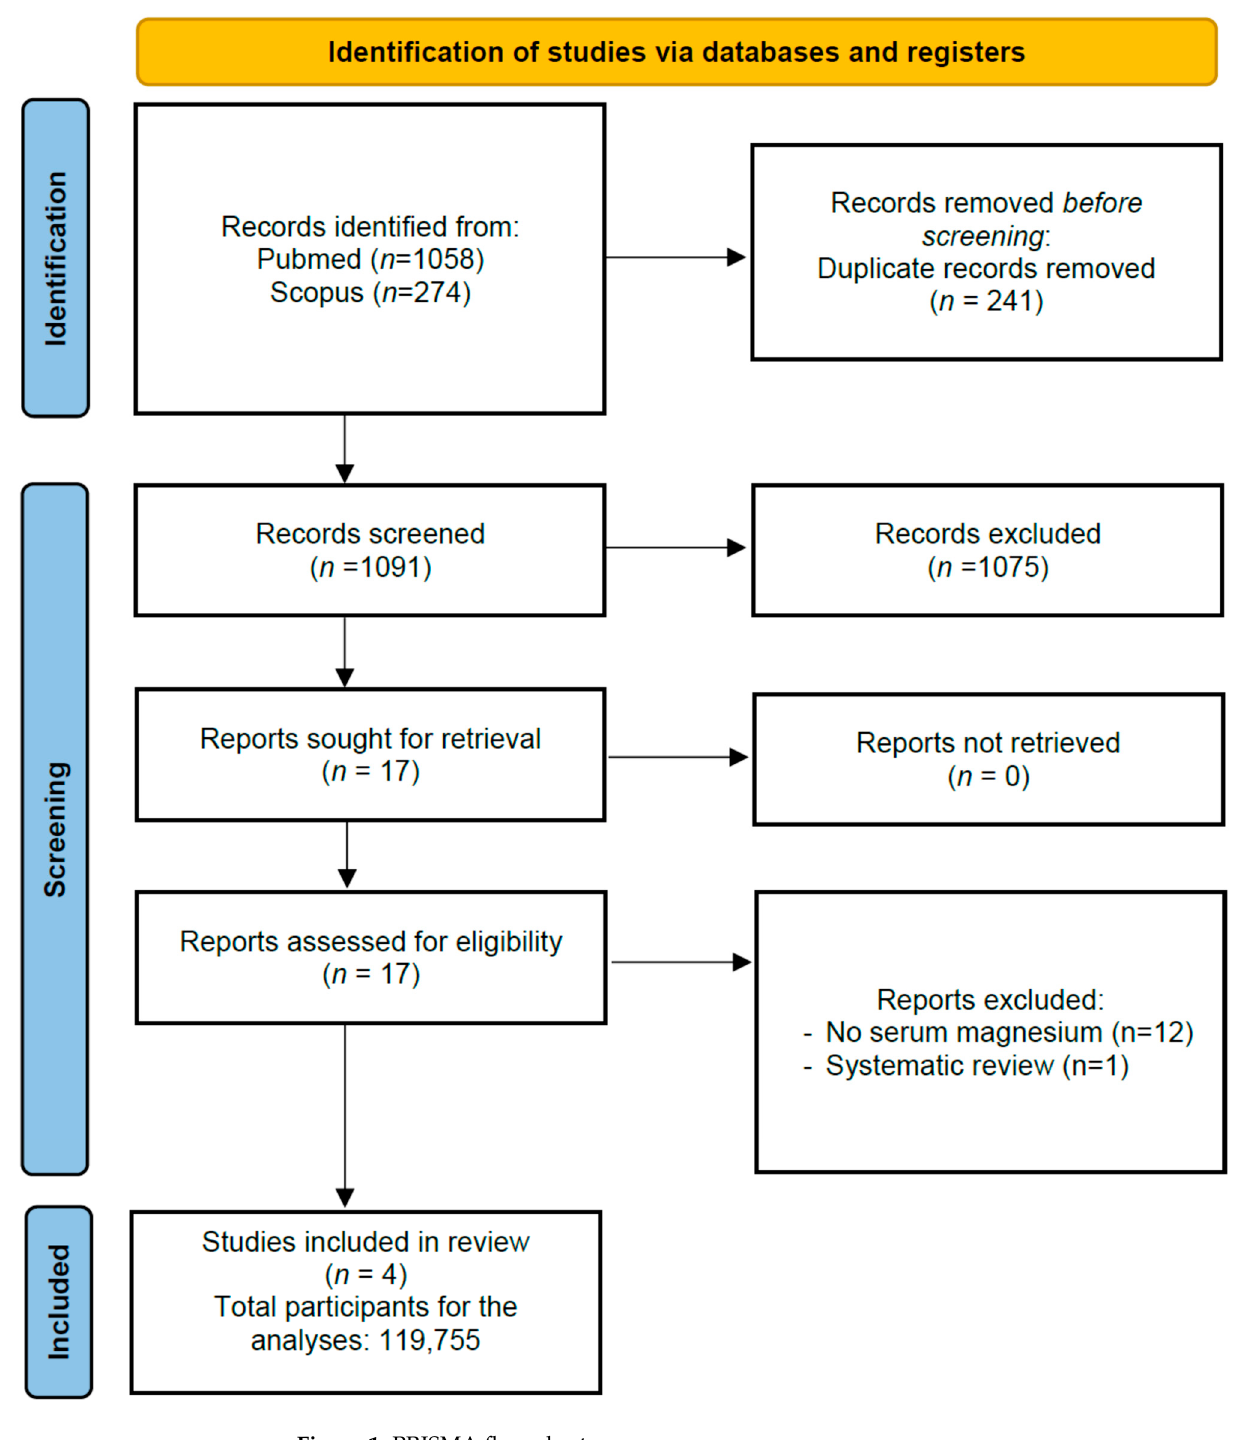
Figure 1. PRISMA flow-chart.